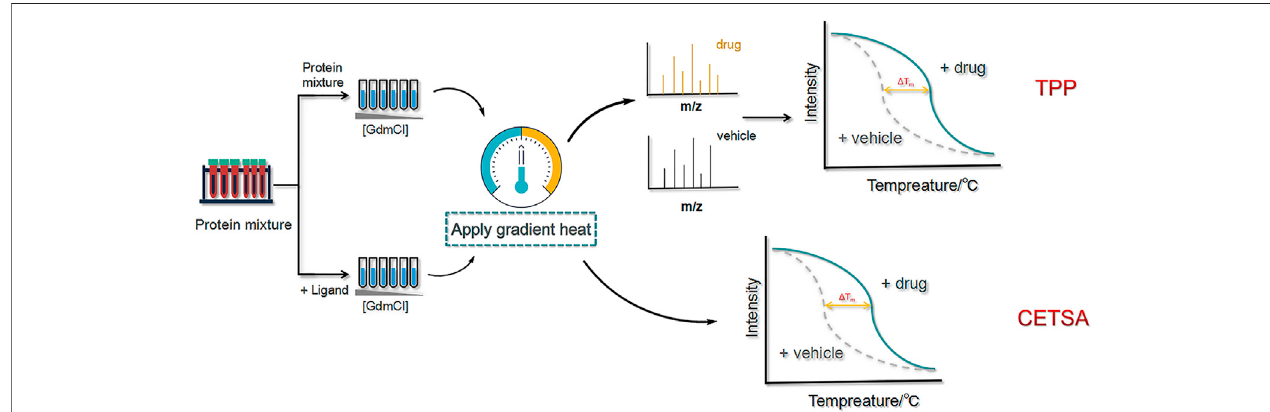
FIGURE 10 | Schematic diagram of the thermal proteome pro fi ling (TPP) and cellular thermal shift assay (CETSA) methods. First, two protein samples (with and without ligand) are dispensed into a buffer containing a chemical denaturant. Then,high-resolution MS is performed using neutron-encoded isobaric mass TMT10 as a labelling reagent, and the complete melting curves of heavily expressed soluble proteins are